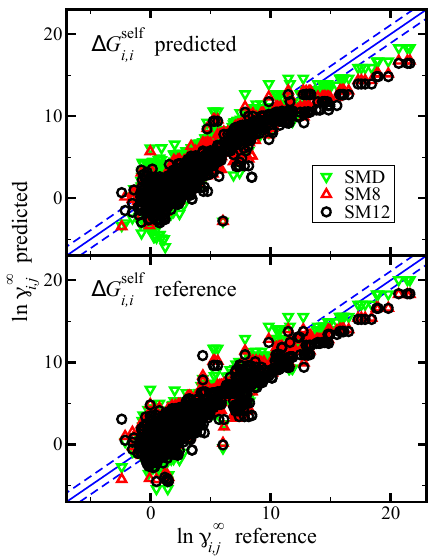
from the DECHEMA. Predictions i , j was predicted using the SM12, SM8, or SMD i , i was computed using i , i